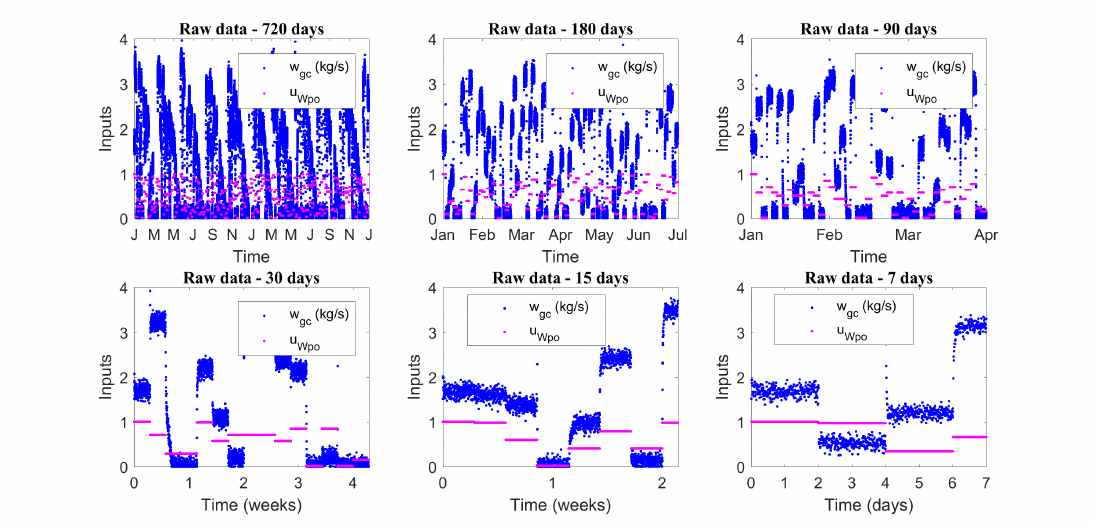
Figure 13. Raw data time serie profiles—Inputs.